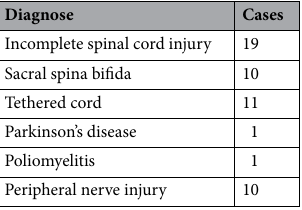
Table 1. Disease composition of 52 NB